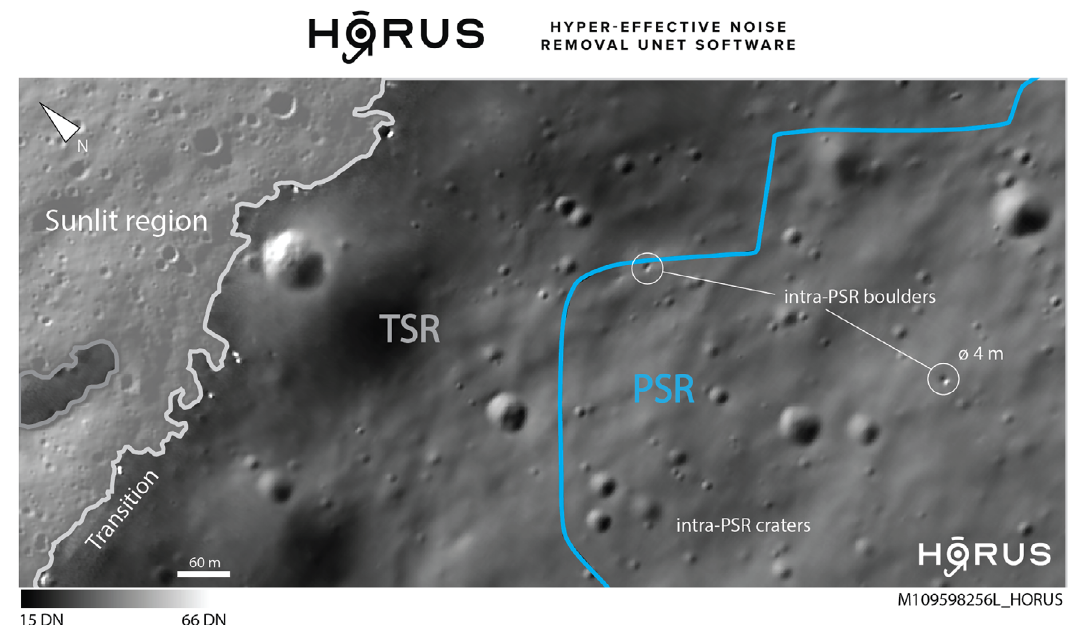
Fig. 1 HORUS — unprecedented views into lunar shadowed regions. Example HORUS image of a potential Artemis candidate permanently shadowed region (PSR) (A004 PSR 3) in the direct vicinity of Shackleton crater, lunar south pole. For the fi rst time, we are able to reveal features in this PSR as small as 3 – 5 m in size. The PSR is outlined in blue, and the NAC-observed (Narrow Angle Camera) transiently shadowed region (TSR) in gray. Intra-TSR/PSR impact craters are clearly visible, just as in the sunlit region; two intra-PSR boulders are highlighted with white circles (both are ~4 m across). Note that the sunlit-shadow transition zone is resolved as well; the range of digital numbers (DN) is shown at the bottom of the fi gure. The sunlit part of the image is slightly transparent to help showcase the shadowed region. The location of this PSR is shown in Fig. 2. In Egyptian mythology, Horus is the son of Isis; this relation represents the authors ’ interest in complementing the existing Lunar Reconnaissance Orbiter NAC processing pipeline Isis3 (Integrated Software for Imagers and Spectrometers, e.g., ref. 64 ). Raw NAC image credits to